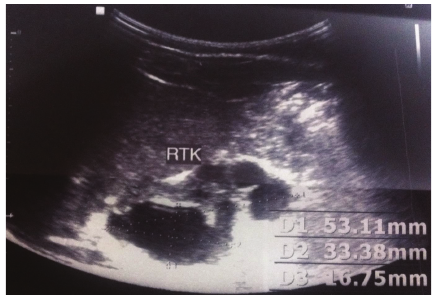
Figure 2: Sonography was done in 6th day which shows a right dysplastic kidney with the largest cyst size measuring 33 ∗ 16 mm after cyst aspiration.